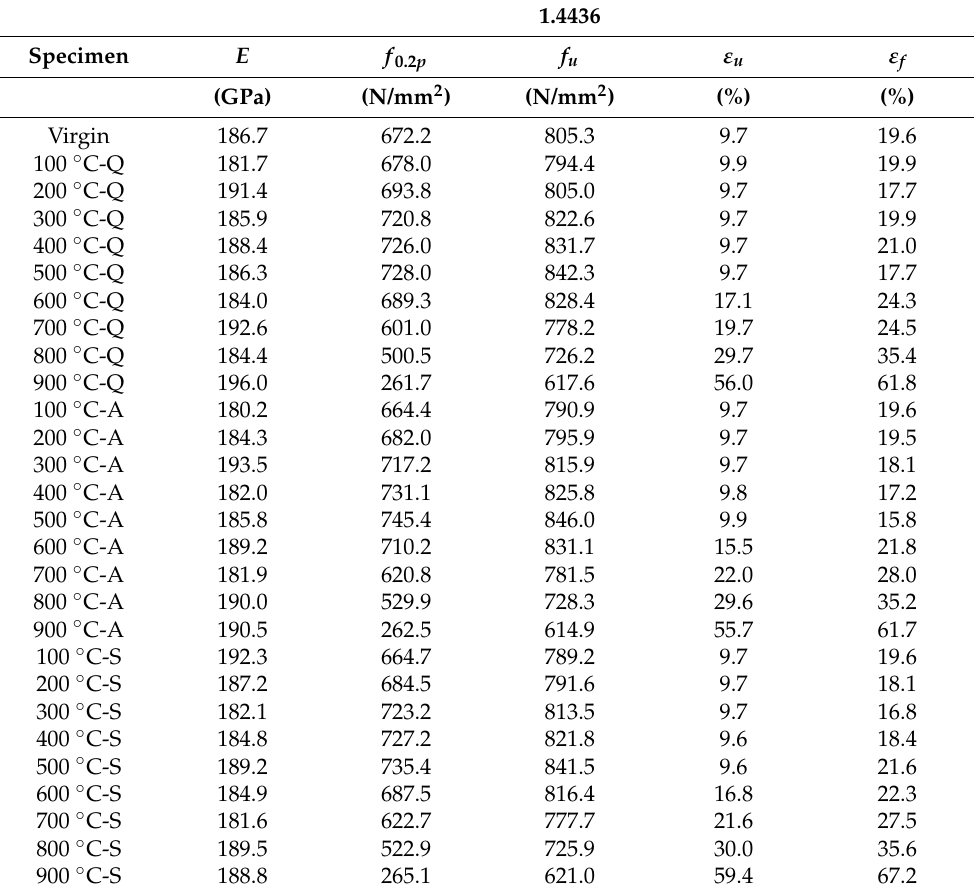
Table 5. Post-fire mechanical properties of grade 1.4436 stainless steel reinforcing